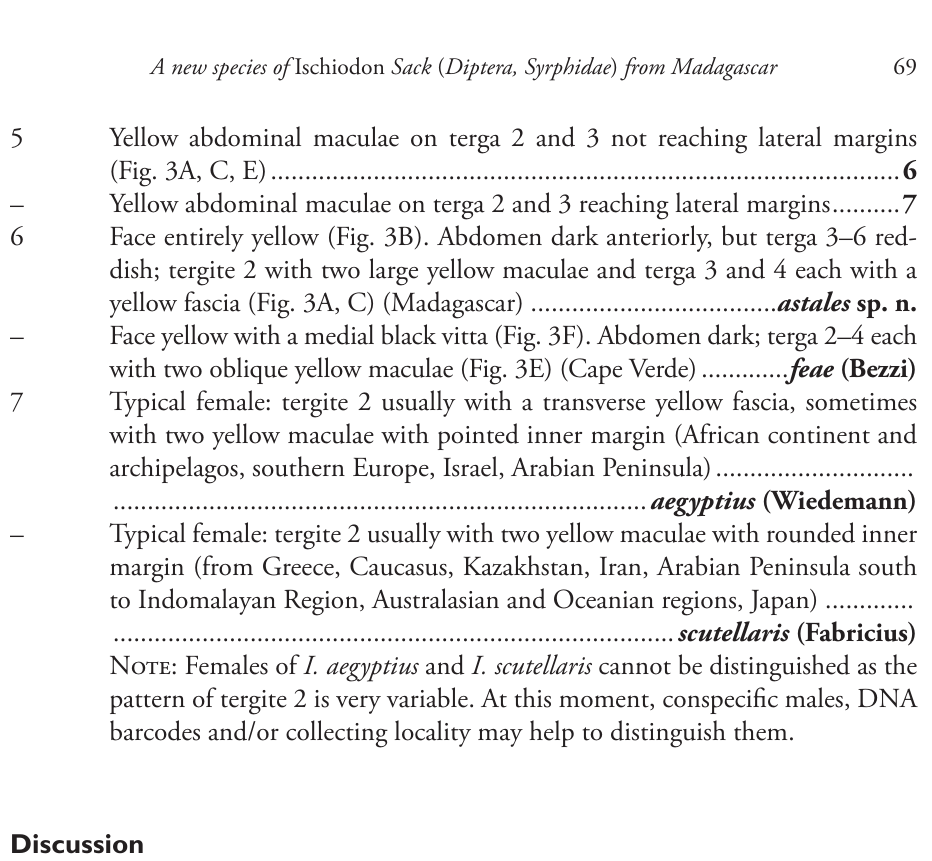
Typical female: tergite 2 usually with two yellow maculae with rounded inner margin (from Greece, Caucasus, Kazakhstan, Iran, Arabian Peninsula